Question: Identify the chart type used in this figure.
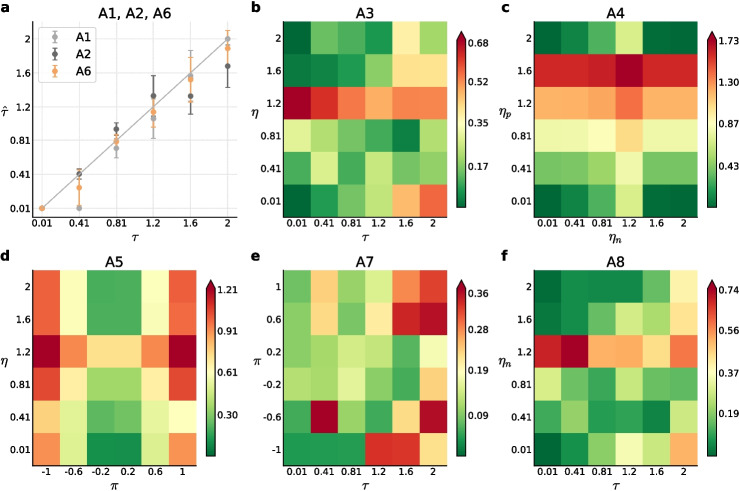
Answer: line